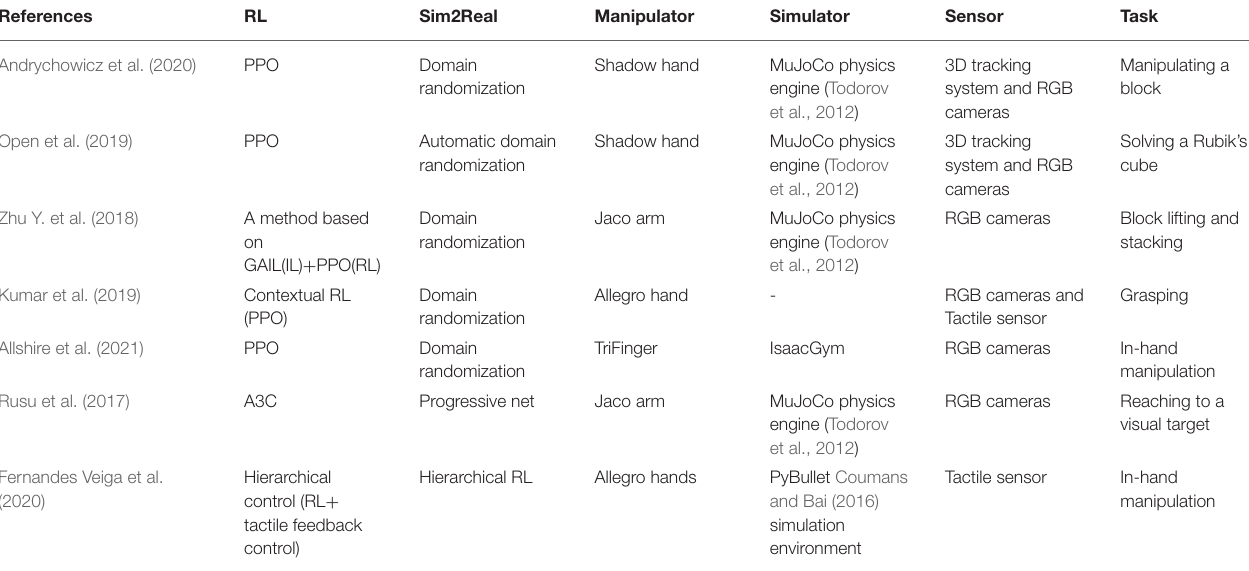
TABLE 7 | Overview of the dexterous manipulation from simulation to